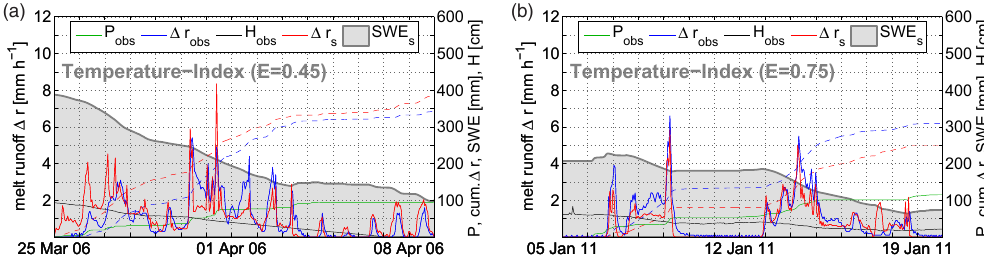
Figure 5. Snowmelt simulations at the point scale using observed meteorological time series at the Torfhaus meteorological station: (a) winter season 2005–2006, (b) winter season 2010–2011. For every simulation run, observed precipitation depth ( P obs ), observed runoff ( (cid:49)r obs , blue line), observed runoff depth (blue dashed line), observed snow depth ( H obs ), simulated runoff ( (cid:49)r sim , red line), simulated runoff depth (red dashed line), and simulated snow water equivalent (SWE s ) are plotted. Model efficiencies E are also given for each run.